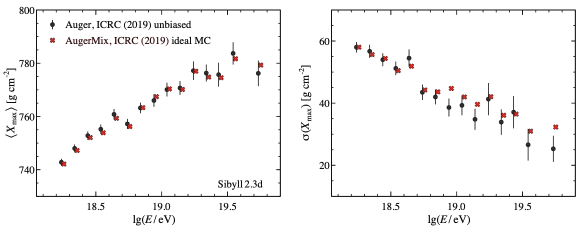
Figure 2. Comparison of (cid:3) X max (cid:4) (left) and σ ( X max ) (right) be- tween the sum of AugerMix weighted templates from Sibyll 2.3d and the measured Auger X max